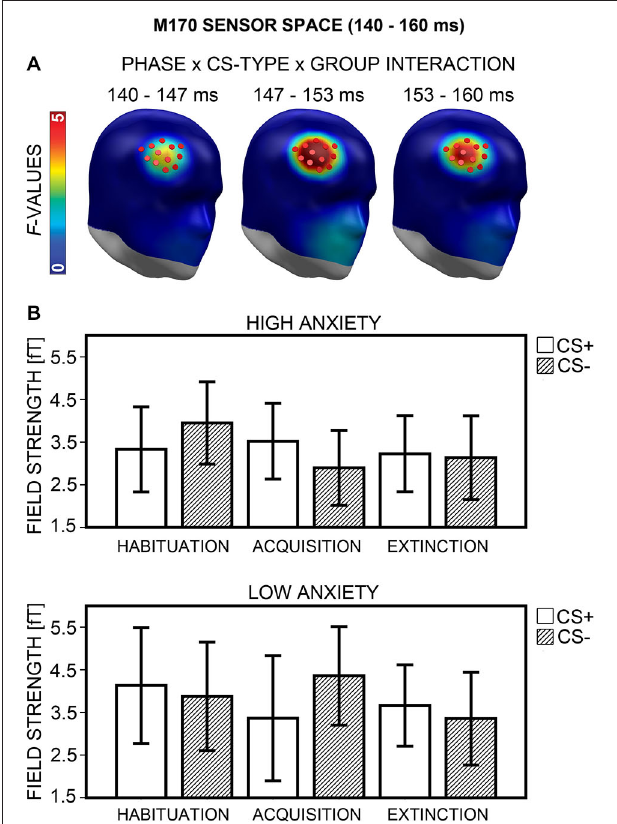
FIGURE 9 | Visualization of the M170 sensor space effect (140–160 ms) . (A) F -values for the Phase × CS-Type × Group interaction calculated for the M170 time-interval are projected onto right frontal view standard heads. Red disks visualize the sensor locations used for post hoc statistical analyses. (B) Mean field strengths (95% confidence intervals) are shown for paired (CS+; white bars) and unpaired (CS − ; striped bars) stimuli for the high and low anxiety groups and the three conditioning